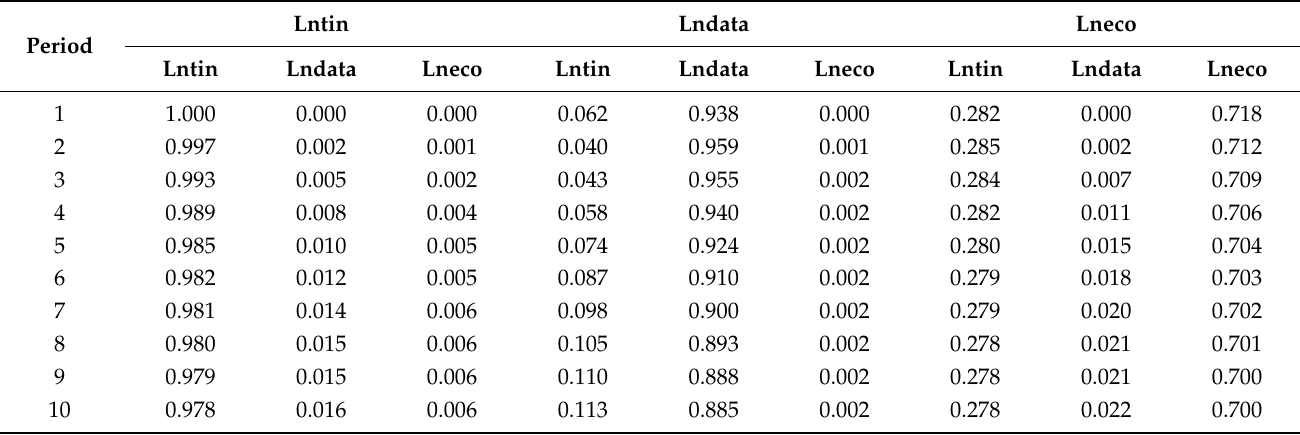
Figure 2. Pulse response results of digitalization, technological innovation, and green economic development. Table 9. Variance decomposition